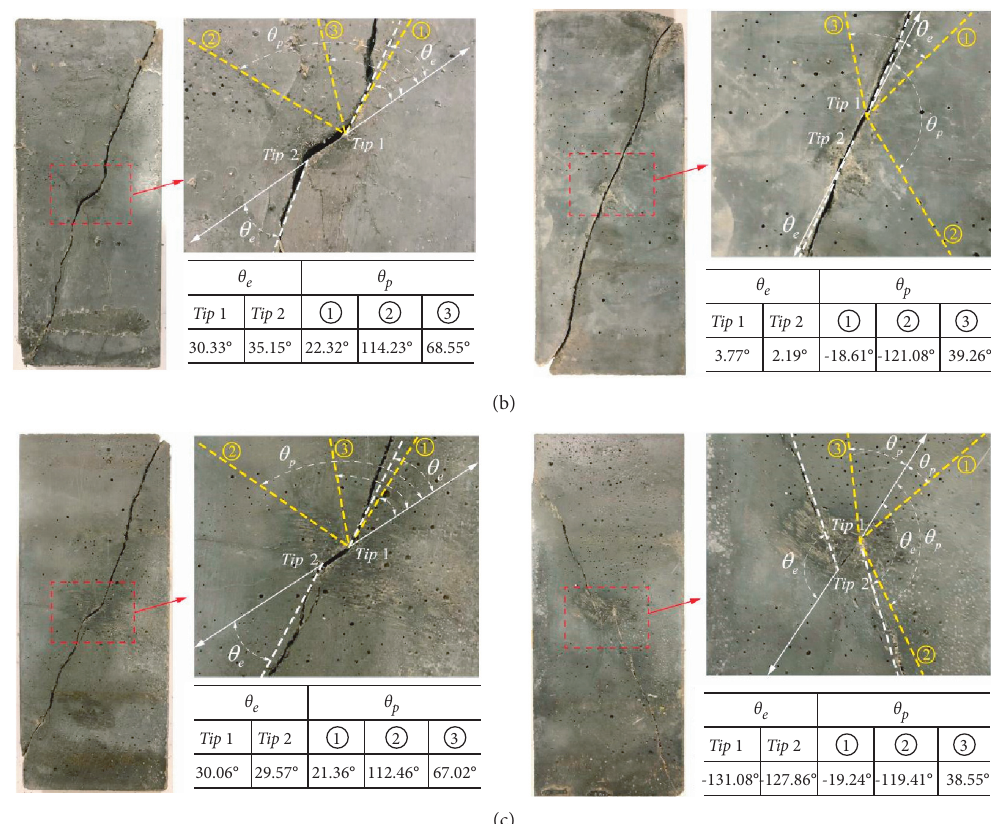
Figure 15: The failure modes of two samples under different confining pressures, and the comparison of experimental and predicted values.